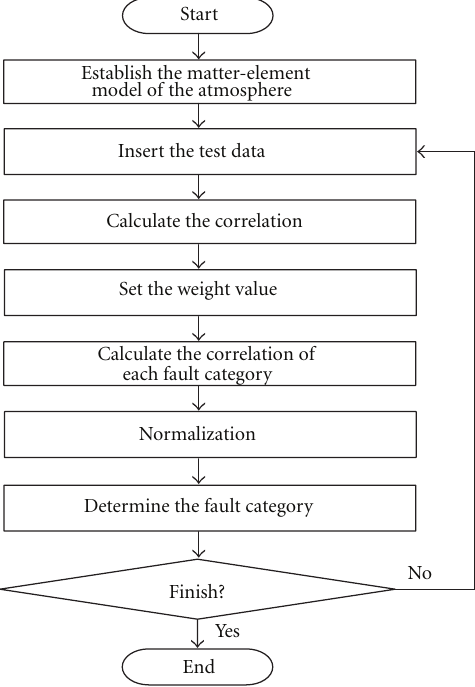
Figure 8: The flowchart of the first stage fault